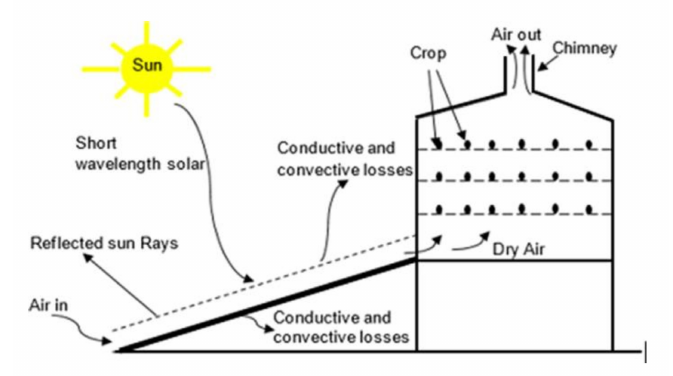
Figure 1. Schematic view of a solar dryer with a solar collector